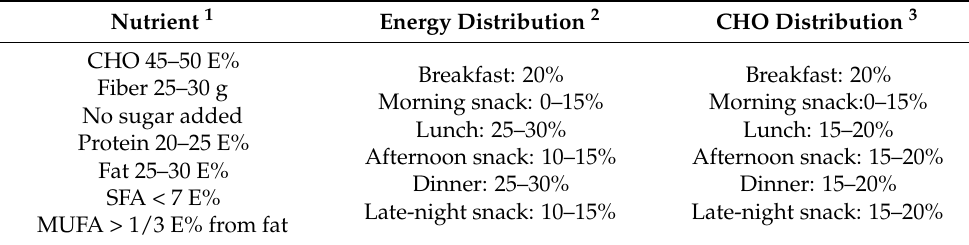
Table 1. Nutrient structure and diet compositions of CRD